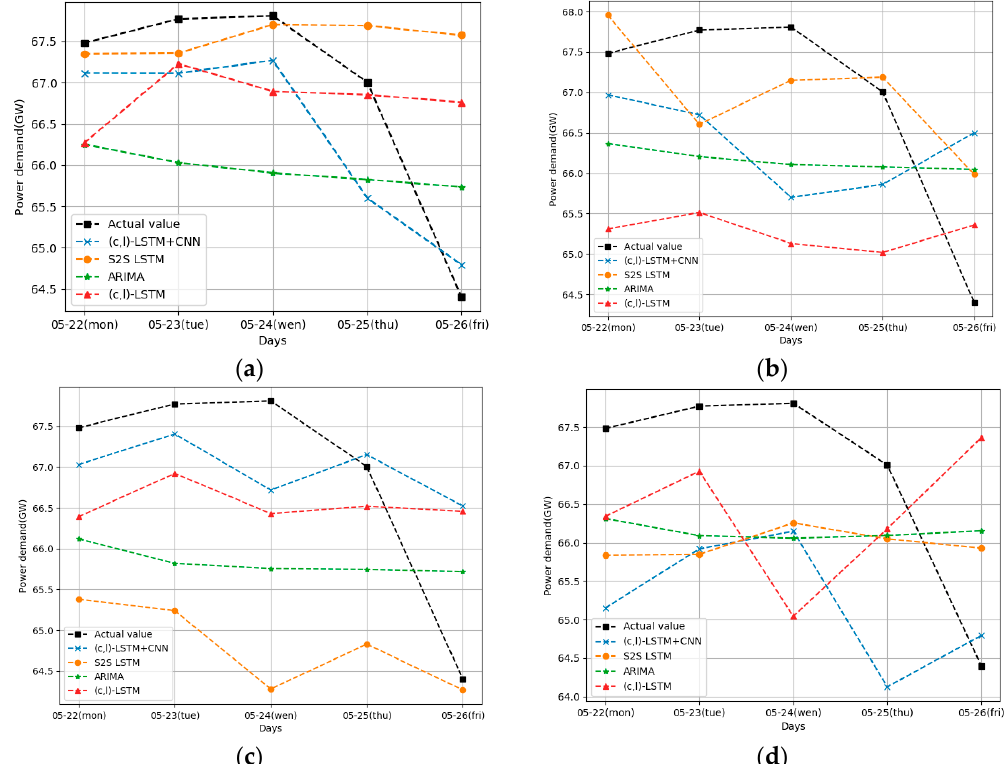
Figure 15. Forecasting performances on d 5 : ( a ) spring; ( b ) summer; ( c ) autumn; ( d ) winter.